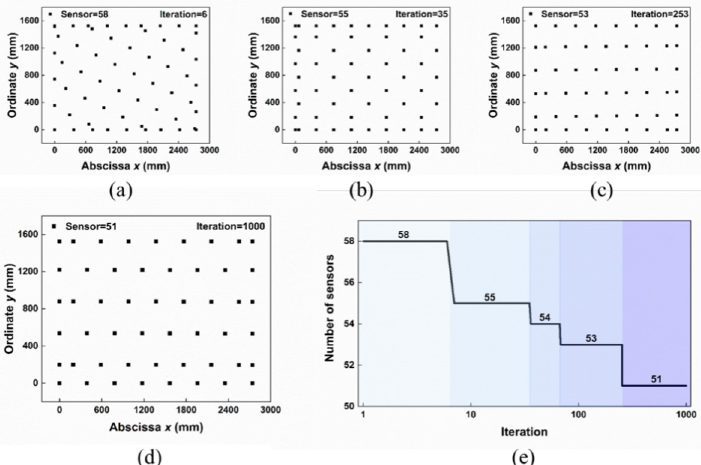
Fig 5. Best sensor distribution in different iteration ((a) 6, (b) 35 and (c) 253) swarms. (d) The optimal sensor distribution after LCSO optimization. (e) The number of sensors with different iterations.